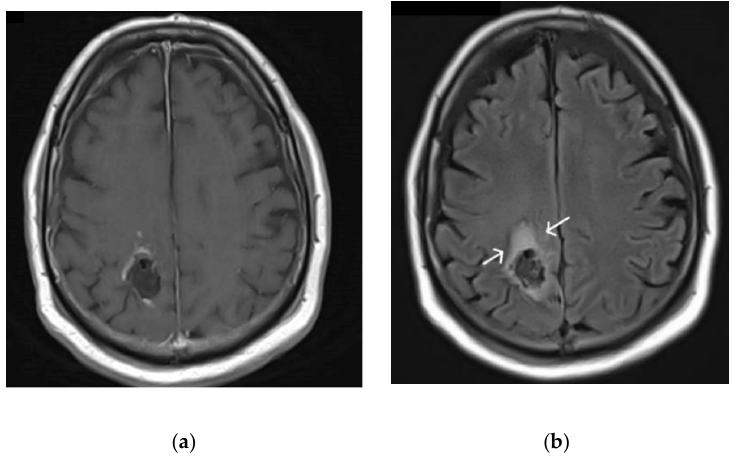
Figure 1. ( a ) T1 gadolinium enhanced MRI sequence demonstrating tumour. ( b ) T2 FLAIR MRI sequence demonstrating significant perilesional oedema, illustrated by the white arrow, where infiltrative tumour is present.